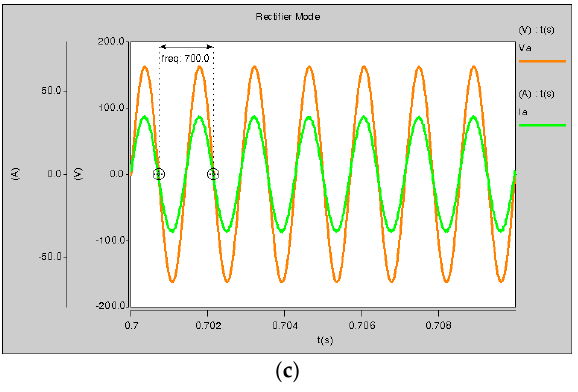
Figure 11. Variable frequency operation in rectifier mode ( a ) 360 Hz; ( b ) 400 Hz; and ( c ) 700 Hz.